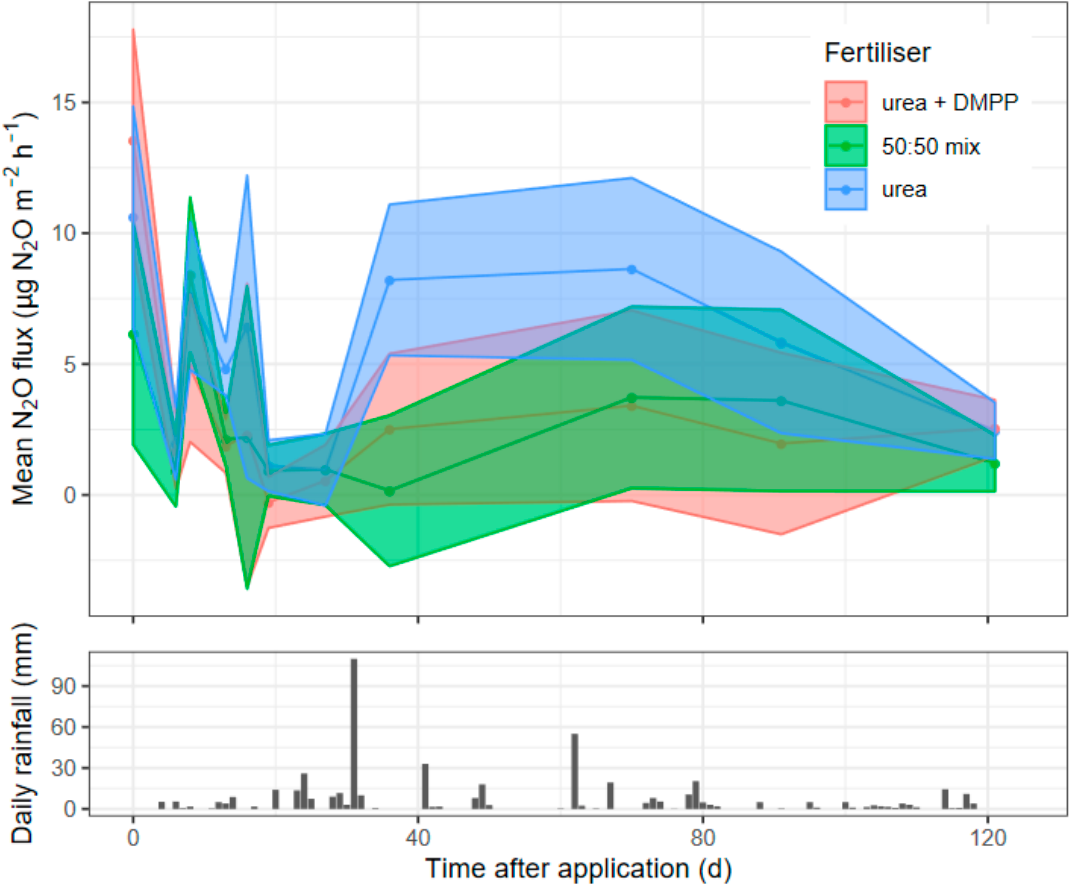
Figure 2. Nitrous oxide fluxes from an acidic Gleysol following application of 90 kg N ha − 1 as urea, urea plus 3,4-dimethylpyrazole phosphate (DMPP) or a 50 / 50 blend of urea and DMPP–urea (50:50 mix). The shaded error on all the plots represents 95% confidence limits.